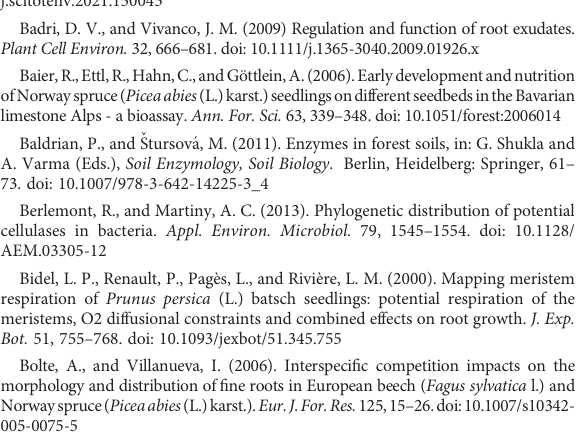
function of vertical distance from the root apex in the regions with different root hair length (RHL). Cellobiohydrolase (CBH); leucine-